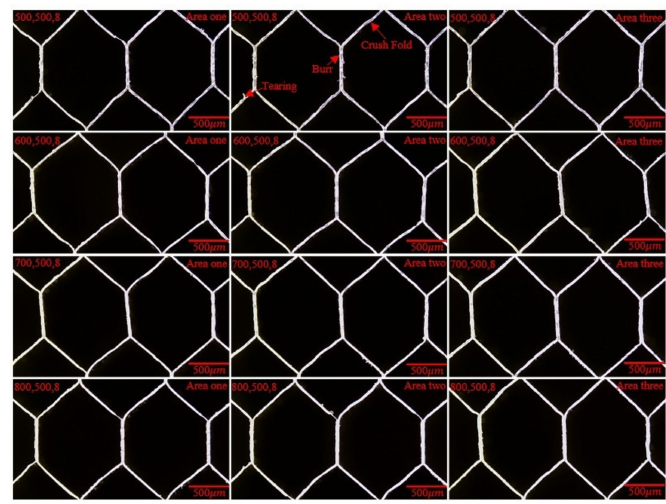
Figure 10. Surface morphology at different spindle speeds.